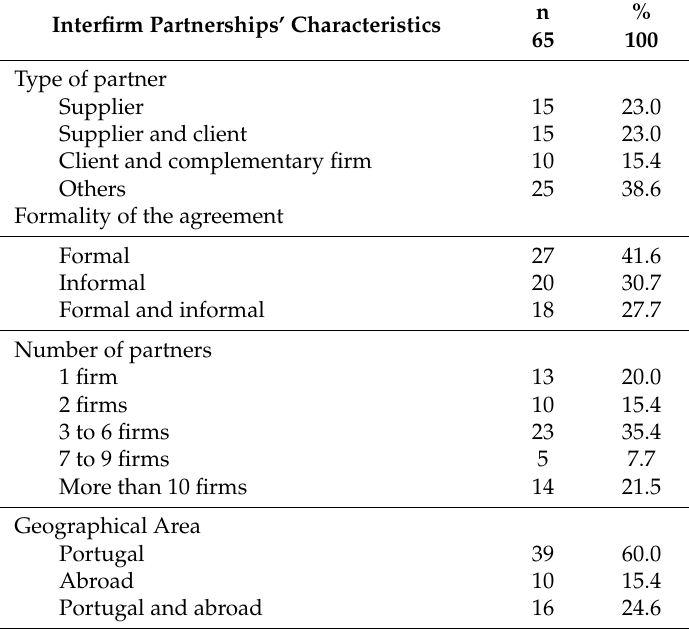
Table 2. Characterization of Interfirm